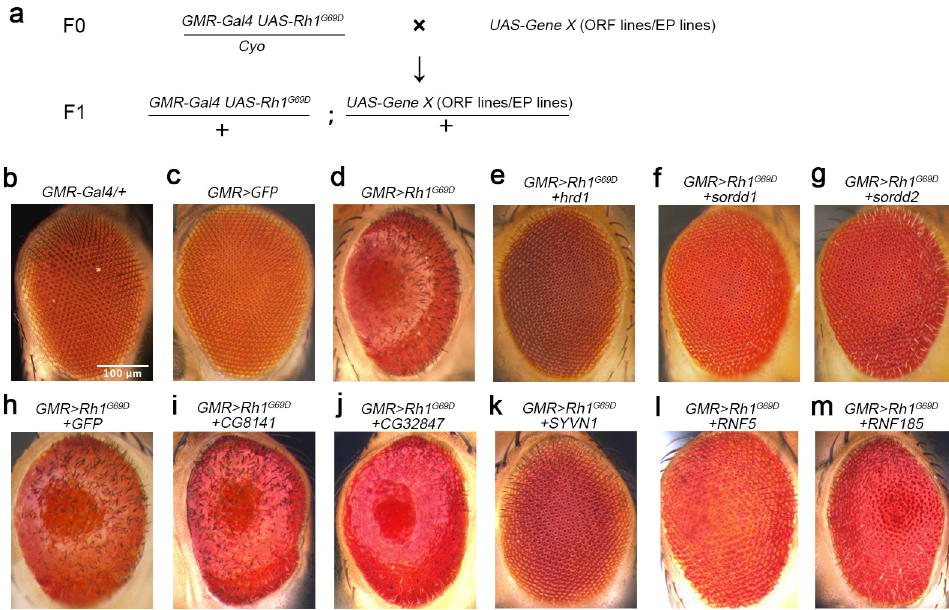
Fig 1. SORDD1 and SORDD2 suppress Rh1 G69D -induced retinal degeneration. (a) The genetic screen used to identify suppressors of Rh1 G69D -induced retinal degeneration. The representative strategy of screening for UAS-cDNAs inserted on the 3rd chromosome is shown. (b-m) Light photomicrographs show the adult eye morphology of (b) GMR-gal4/+ , (c) GMR-Gal4 > GFP ( GMR-Gal4/+;UAS-GFP/+ ) (d) GMR > Rh1 G69D ( GMR-Gal4 UAS-Rh1 G69D /+ ),